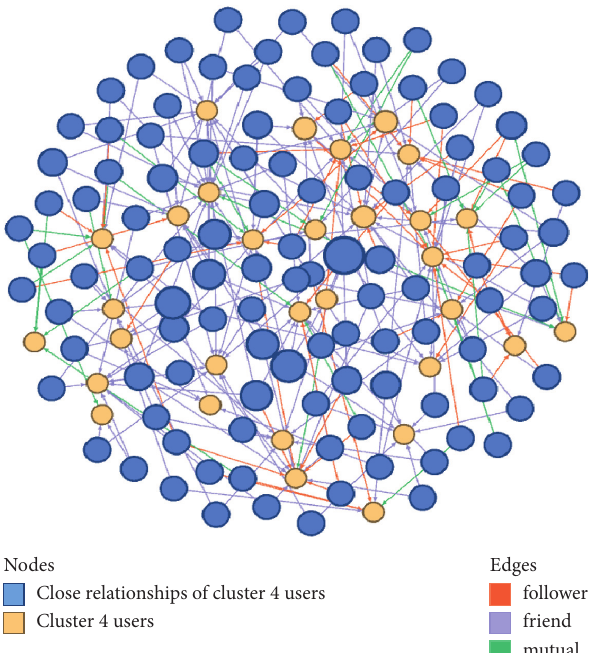
Figure 6: Neighborhood for accounts included in cluster 4 of Scenario 1.